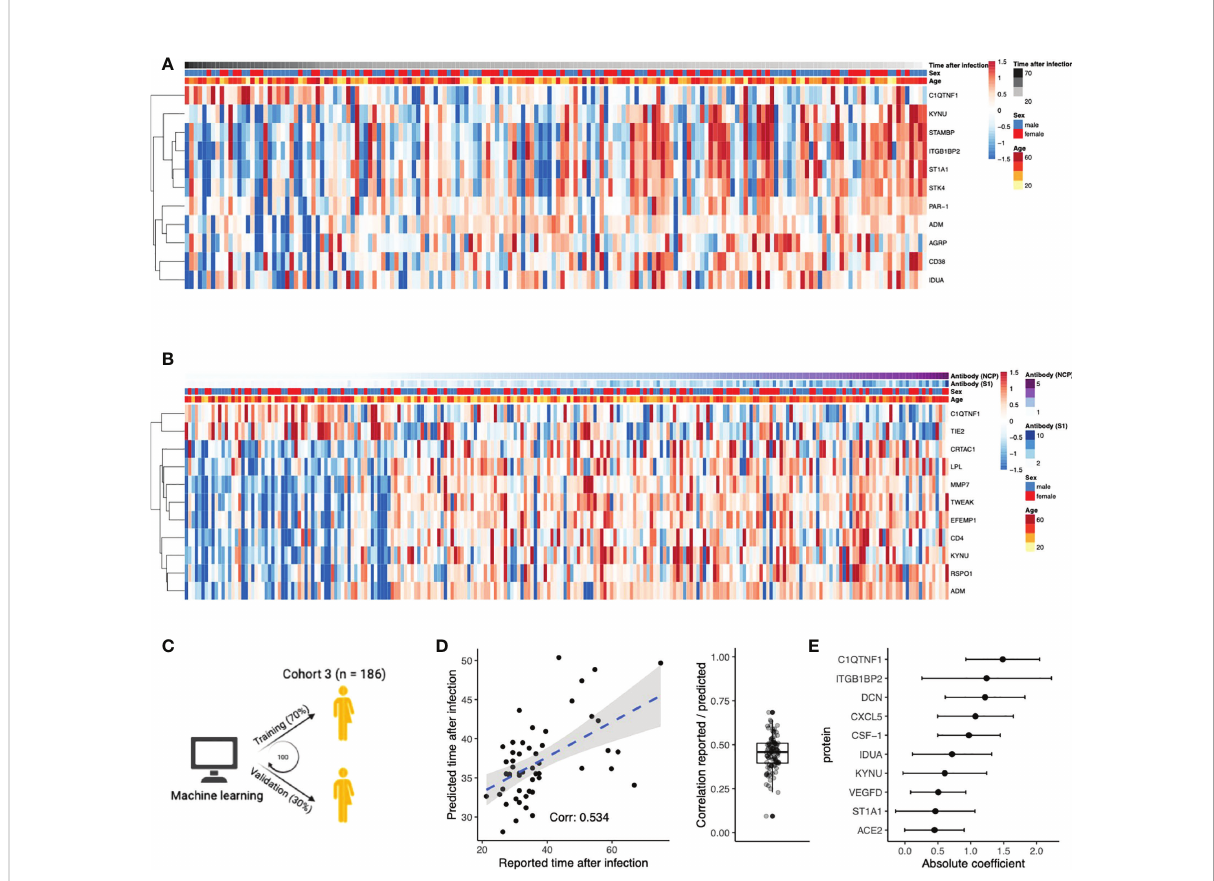
FIGURE 3 Circulating proteins predict COVID-19 recovery time. (A) Proteins signi fi cantly correlated to time the after infection in post-COVID-19 individuals. The time after infection is de fi ned as the time between symptom offset and sampling and thus indicates the time after self-reported recovery per individual. Each row represents a protein, and each column represents a sample. Individuals are ordered by increasing time after recovery. (B) Proteins signi fi cantly correlated to either SARS-CoV-2 Spike 1 (S1) antibody or nucleocapsid protein (NCP) antibody concentrations in post-COVID-19 individuals. Each row represents a protein, and each column represents a sample. Samples are ordered in increasing NCP antibody concentrations. (C) Schematic overview of the training process for an elastic net linear regression model to predict time after SARS- CoV-2 infection. 70% of the data from post-COVID-19 individuals was used for training, and 30% for validation. Hundred independent training iterations were performed and combined to avoid potential bias. (D) Scatterplot showing the relation between the reported time after SARS- CoV-2 infection in days (x-axis) versus the predicted time after SARS-CoV-2 infection in days (y-axis) of one random run of the predictive model. The blue line represents a linear regression model fi tted to the data, with standard error depicted in gray. Correlation between these values is a good indicator of the quality of the prediction. The boxplot shows the correlation between the predicted and reported values in the validation data over 100 independent runs. Boxplot center line: median, box limits: 1 st and 3 rd quartiles. Whiskers: 1,5 x interquartile range. (E) Mean coef fi cients per protein were calculated over 100 independent training runs for the model. The top ten proteins with the highest absolute mean coef fi cients are shown. Dots indicate the mean absolute mean coef fi cient per protein, and error bars indicate standard